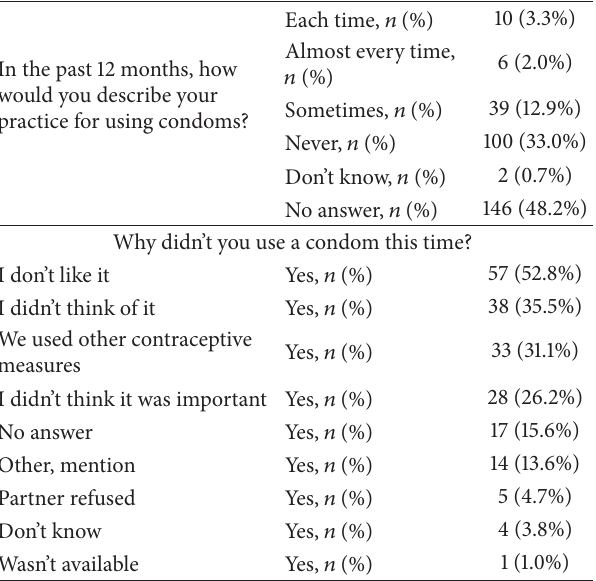
Table 2: Condom usage.